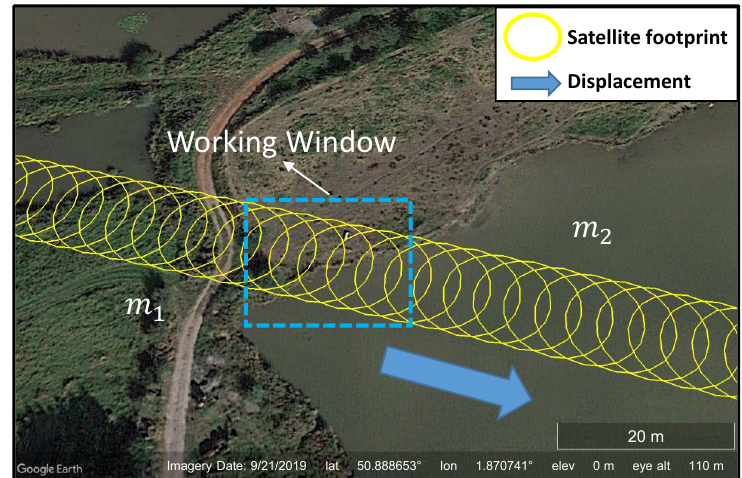
Figure 3. Satellite footprints displacement from one area to another. The area is located at (50.888653 ◦ N, 1.870741 ◦ E). m 1 and m 2 represent the mean values of the GNSS signal amplitudes when the ellipses are on land and on water, respectively.